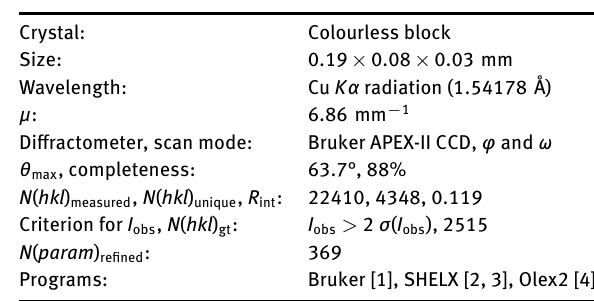
Table 1: Data collection and